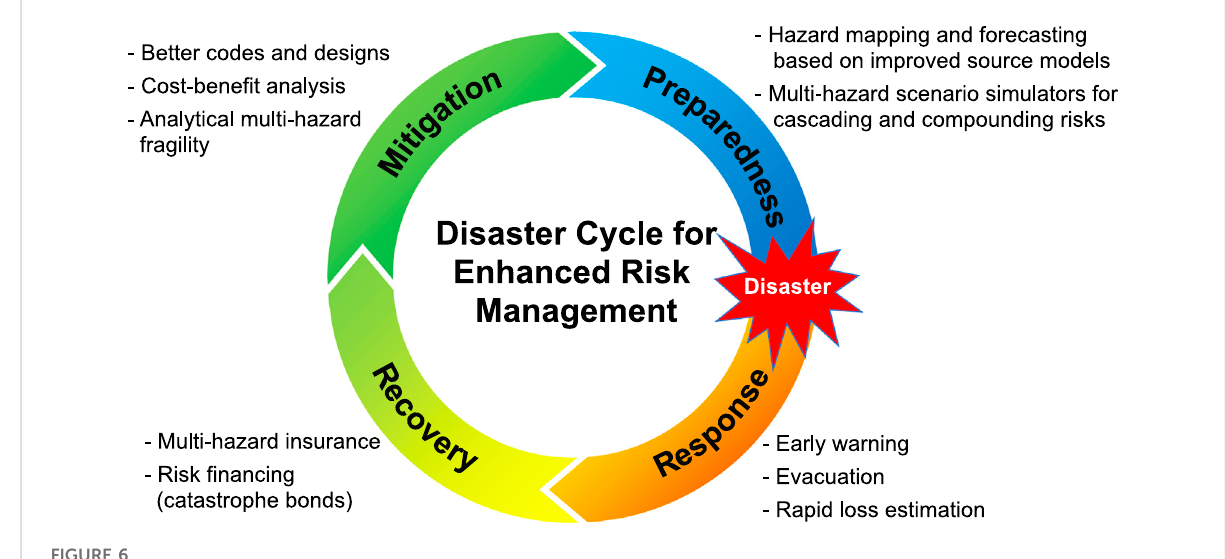
FIGURE 6 Disaster management cycle for enhanced earthquake-tsunami risk